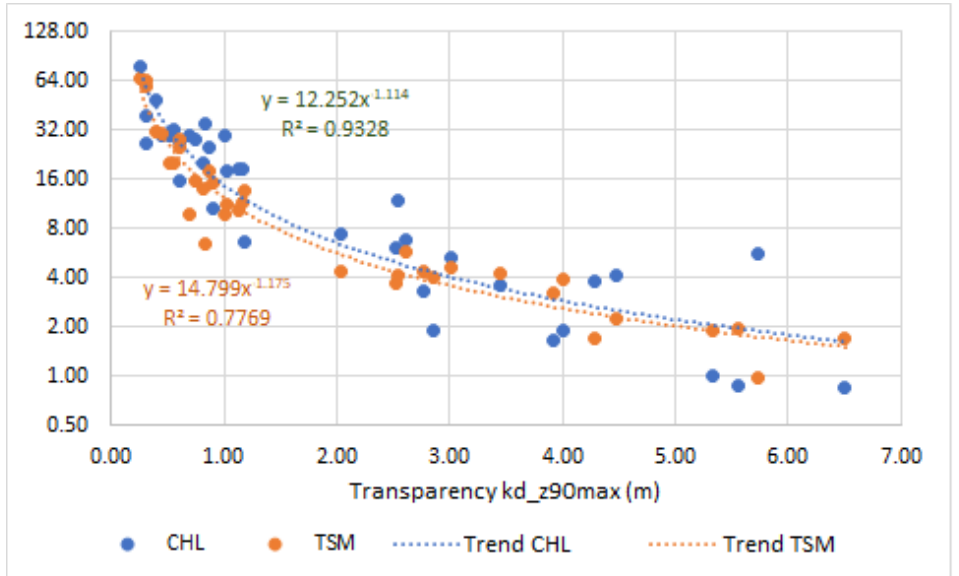
Figure 6. Representation of water transparency values (kd_z90max) versus chlorophyll a concentra- tion in mg/m 3 (CHL) and suspended matter in mg/L (TSM). For each variable, the trend line, the adjust equation and its coefficient of determination are represented.